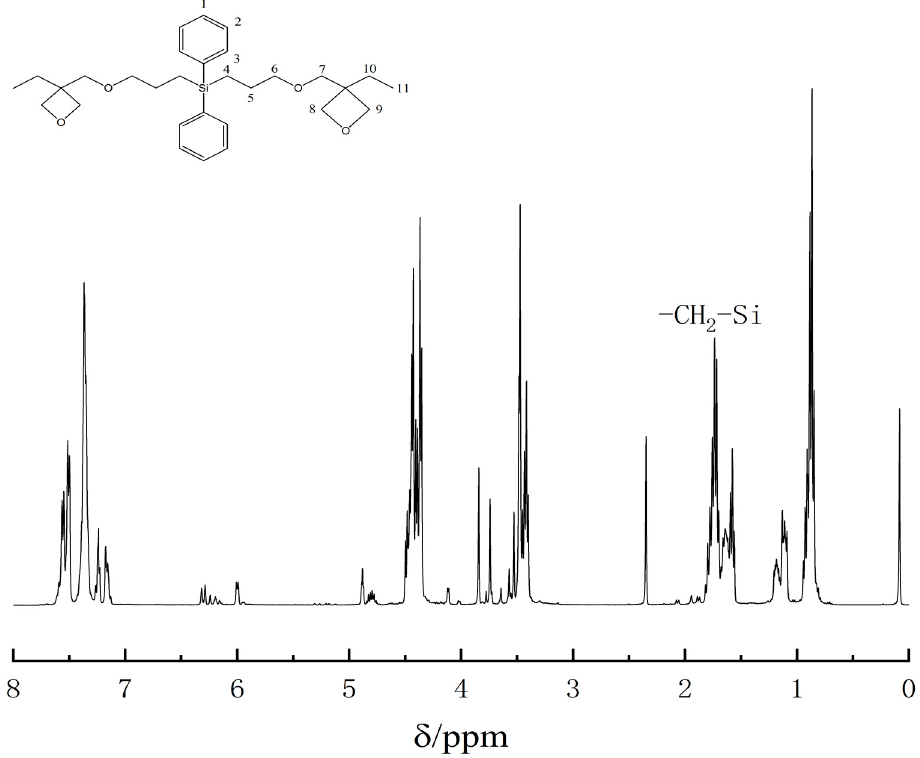
Figure 7. The hydrogen spectrum of bis[(3-ethyl-3-methoxyoxetane)propyl]diphenylsilane. Table 3. Analytical table of the 1 H-NMR spectrum for bis[(3-ethyl-3-methoxyoxetane)propyl]di- phenylsilane.